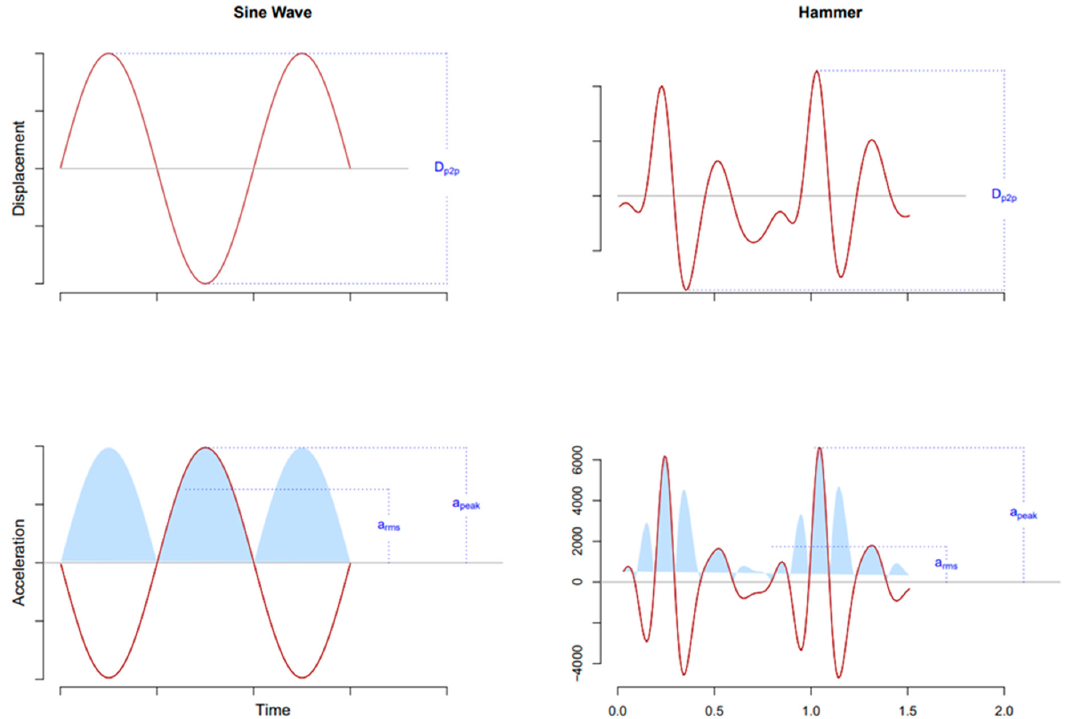
Figure 2. Displacement and accelerations for sine wave and hammer oscillations: displacement and accelerations are only mathematically related for sinusoidal oscillations. Abbreviations: p2p = peak-to-peak; RMS = root-mean-square. Example ber of cycles per second. The vibration magnitude is expressed as peak-to-peak displace- ment (D peak-to-peak , in mm, defined as the distance between minimal and maximal vertical positions of the platform), peak acceleration (a peak , in g, defined as maximal vertical accel- eration within a cycle), and root-mean-square acceleration (a rms , in g). During the inter- vention, a vibration frequency of xx Hz was used, and the subjects’ feet received D peak-to- peak of x mm, a peak of y g, and a rms of z g. Item 5: Whether and how the vibration parameters were verified Explanation Vibration parameters often differ from manufacturer specifications, and the trueness of parameters will change during any device’s lifetime [33]. Hence, in addition to the man- ufacturer’s statements, vibration parameters have to be regularly assessed in practice. High-quality studies, therefore, should report how the vibration parameters were veri- fied. If this is not possible, then the manufacturers’ values should be reported and stated as such. This is straightforward to do via accelerometers that are attached at the repre- sentative spot(s). Alternatively, one could also assess the displacements with laser dis- tance measurements. In any case, the measurement device should capture frequency com- ponents of 500 Hz or higher. Measurements should not only be taken with the unloaded vibration device but foremost while a person is performing the interventional exercises. Since many vibration devices do not provide pure sinusoidal vibration, a set of parameters has to be derived [34–37], including but not limited to peak-to-peak displacement, peak acceleration, and rms acceleration [38]. In addition, it is recommended to provide a spec-